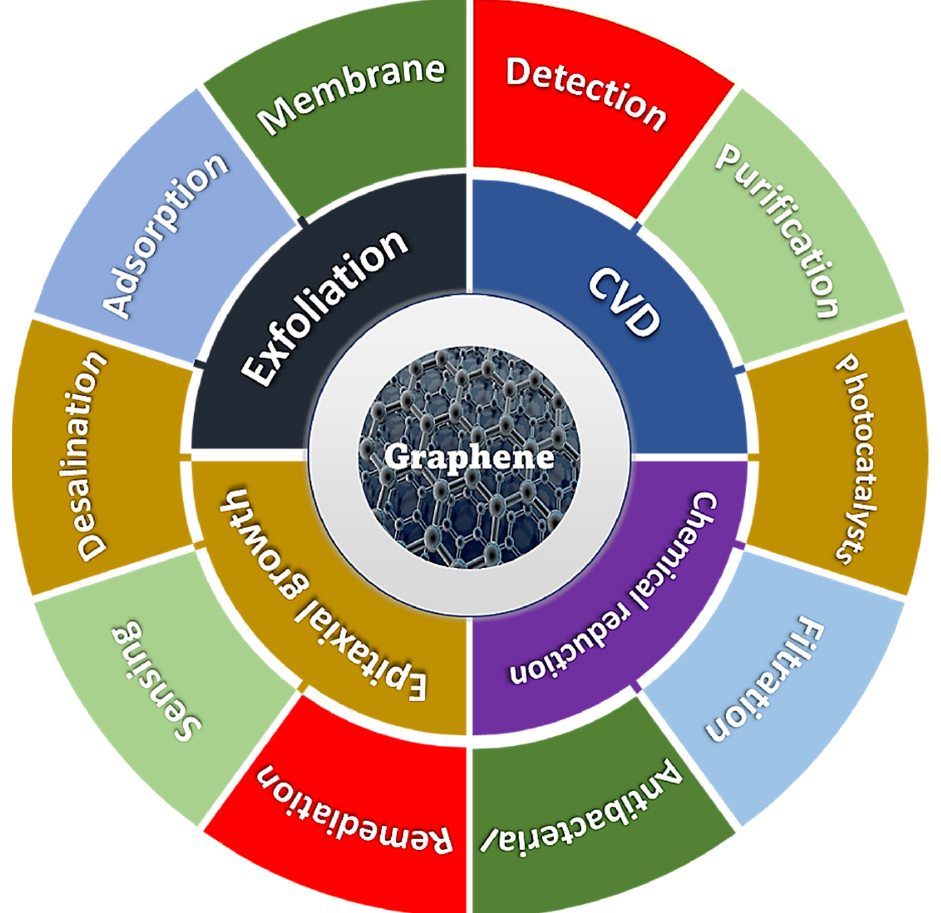
Figure 4. Graphical interpretation of synthesis techniques and environmental applications of gra-